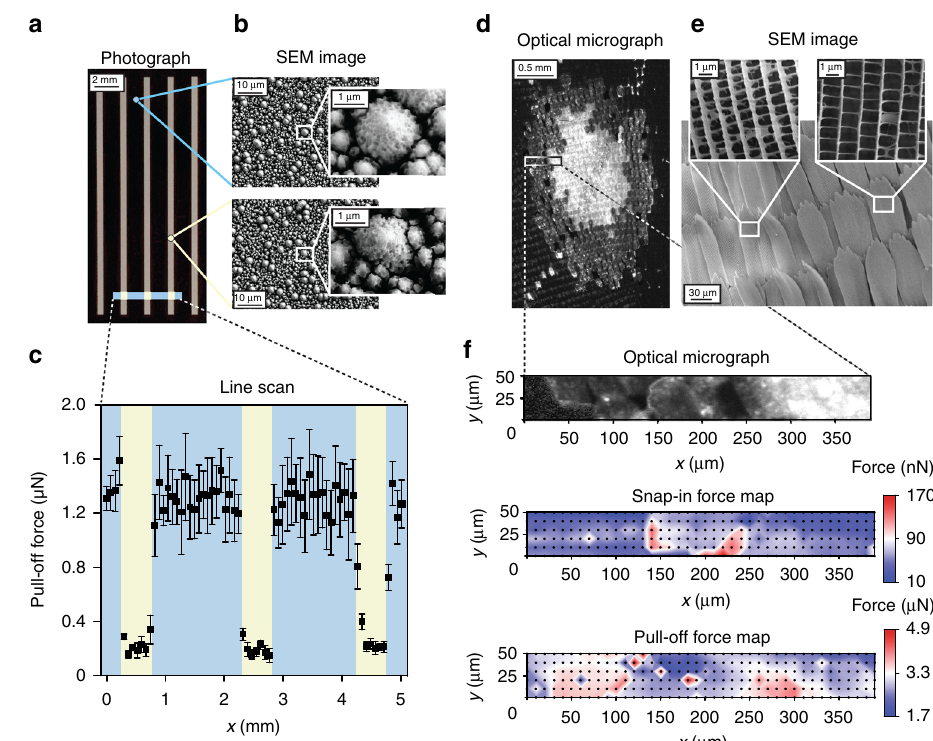
Fig. 4 Detecting spatial variation of small (nN to µ N) wetting forces. a – c Line scan at 75 µ m resolution over superhydrophobic-superhydrophobic patterns of silicon nanograss with slightly different surface topography shows consistent difference in pull-off force. The error bars in c denote standard deviation of three measurements. d – f Area scan at 10 µ m resolution over striped blue crow butter fl y wing eyespot, where optically and topographically different surface structure is re fl ected in the corresponding wetting force